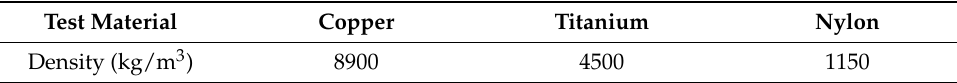
Figure 15. Inline monitoring sensor installed on a pin-disk test rig. Table 2. The material of the test piece of the